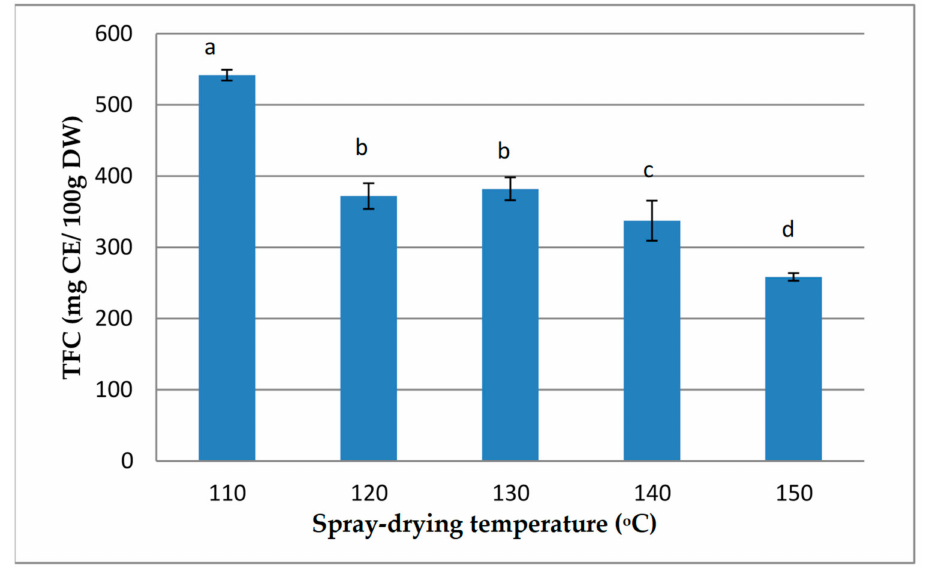
Figure 5. Total flavonoid content (TFC) of lemongrass leaf extract powders at different spray-drying temperatures. All data are the mean ± SD. Values with different letters are significantly different ( p <